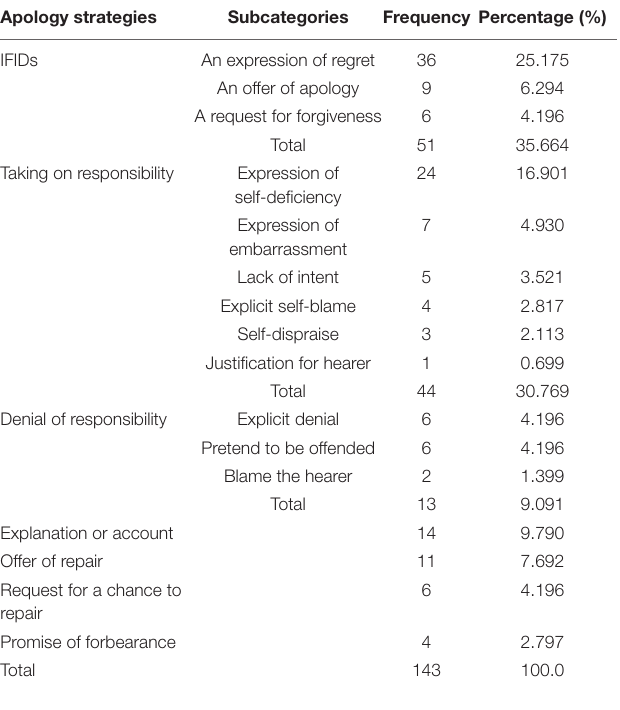
TABLE 3 | Apology strategies used in the